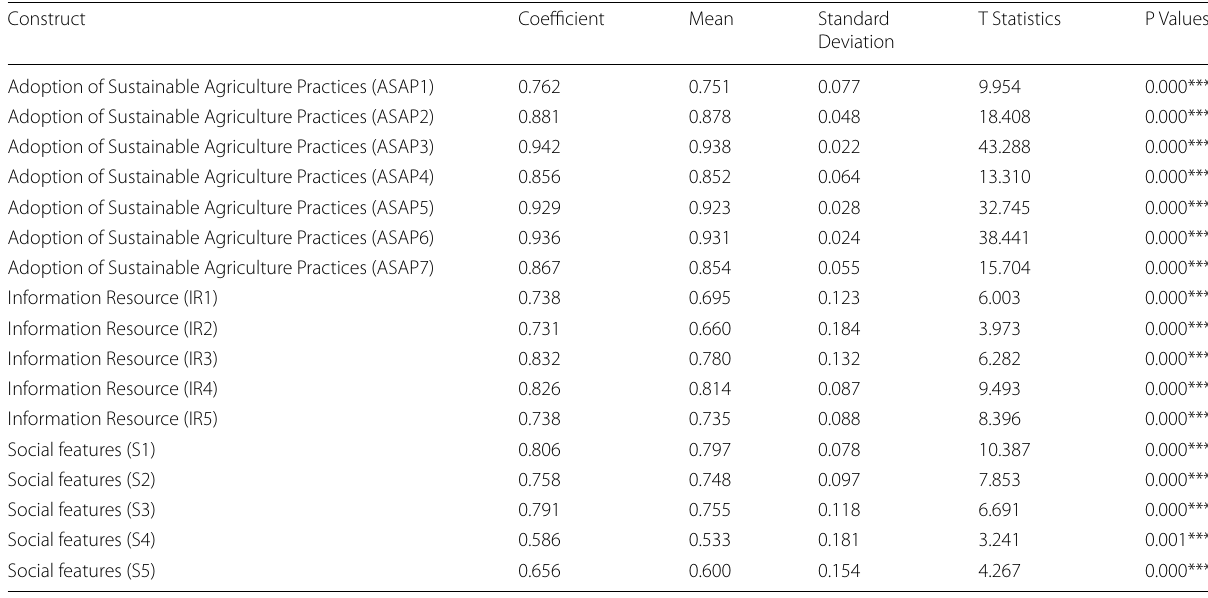
Table 6 Outer loadings of variables on perceived sustainable agriculture adoption as a climate change mitigation strategy